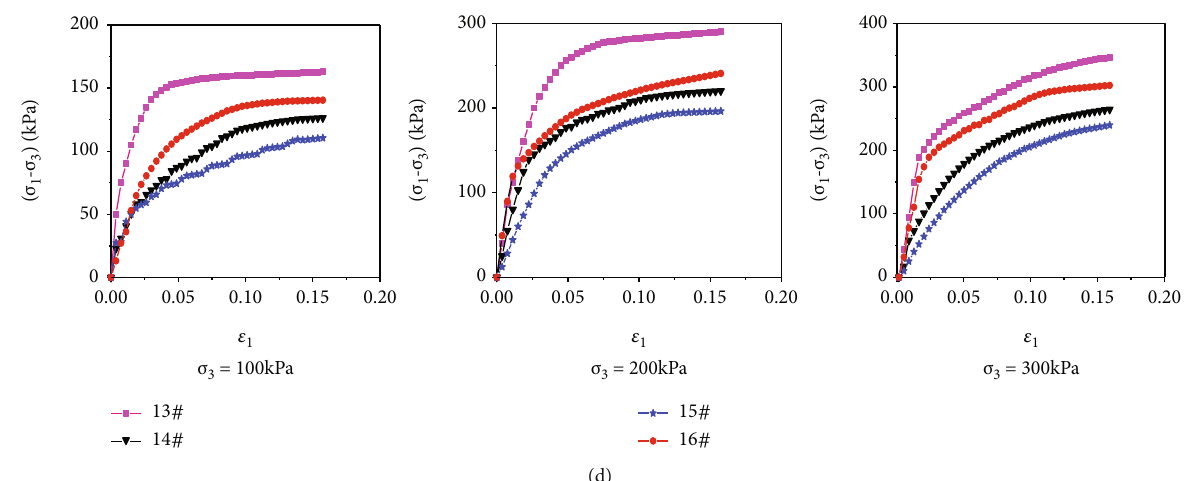
Figure 5: The stress-strain curves variation of vegetated coal-bearing soil specimens: (a) no D-W cycles; (b) one D-W cycles; (c) three D-W cycles; (d) fi ve D-W